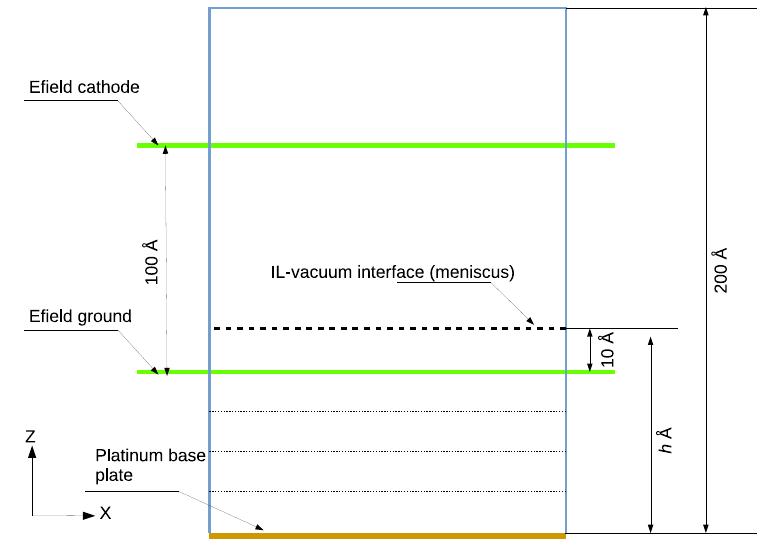
Figure 7. Schematic of the simulation domain used for the bulk simulations to investigate cation-anion separation